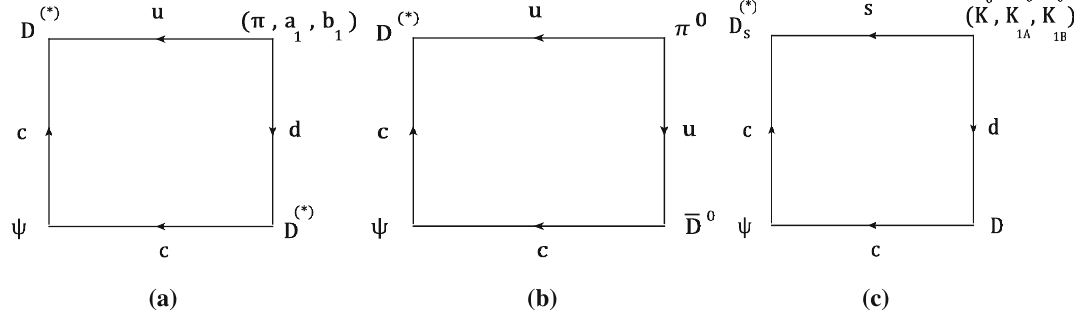
( b − )) vertices can 1 1